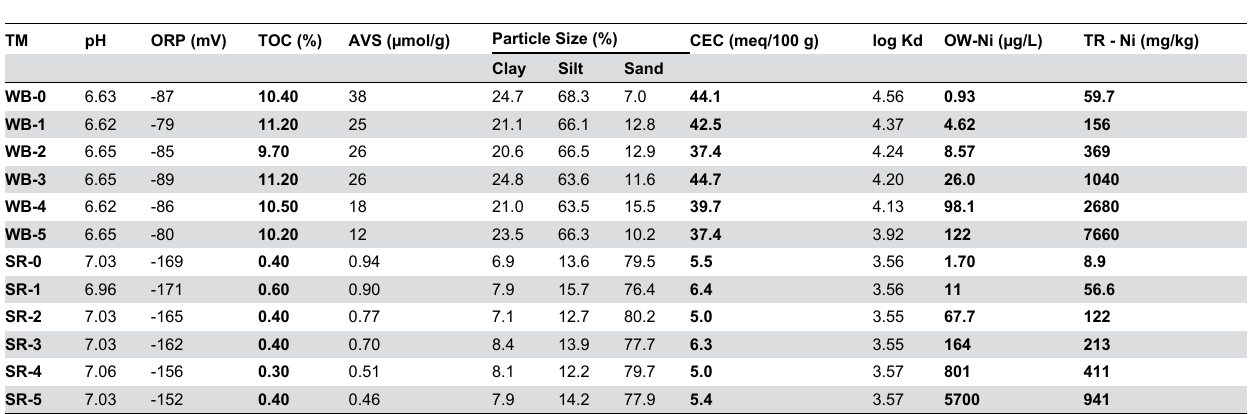
Table 4. Physico-chemical characteristics of nickel-spiked